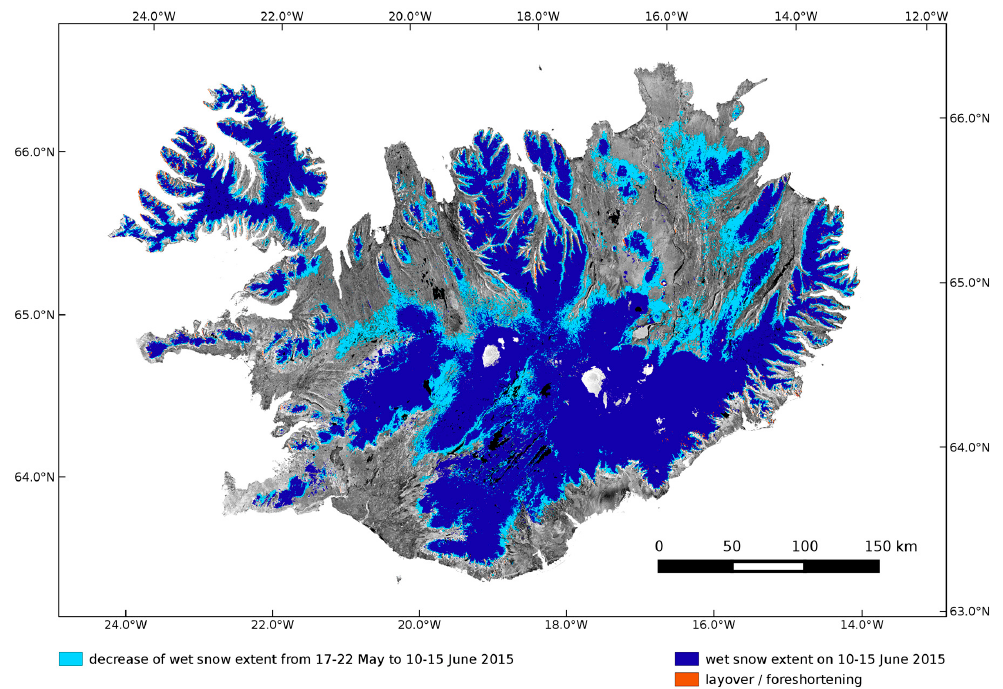
Figure 6. Map of snowmelt area extent in Iceland, derived from Sentinel-1 data of 17, 19 and 22 May 2015 (Date 1) and 10, 12, and 15 June 2015 (Date 2). Light blue: decrease of snow extent between Date 1 and Date 2. Dark blue: snowmelt area on Date 2. Light grey: dry snow on ice caps; white: water surfaces; orange: mask of layover and foreshortening. Background: S1 SAR amplitude image, VV polarizations.